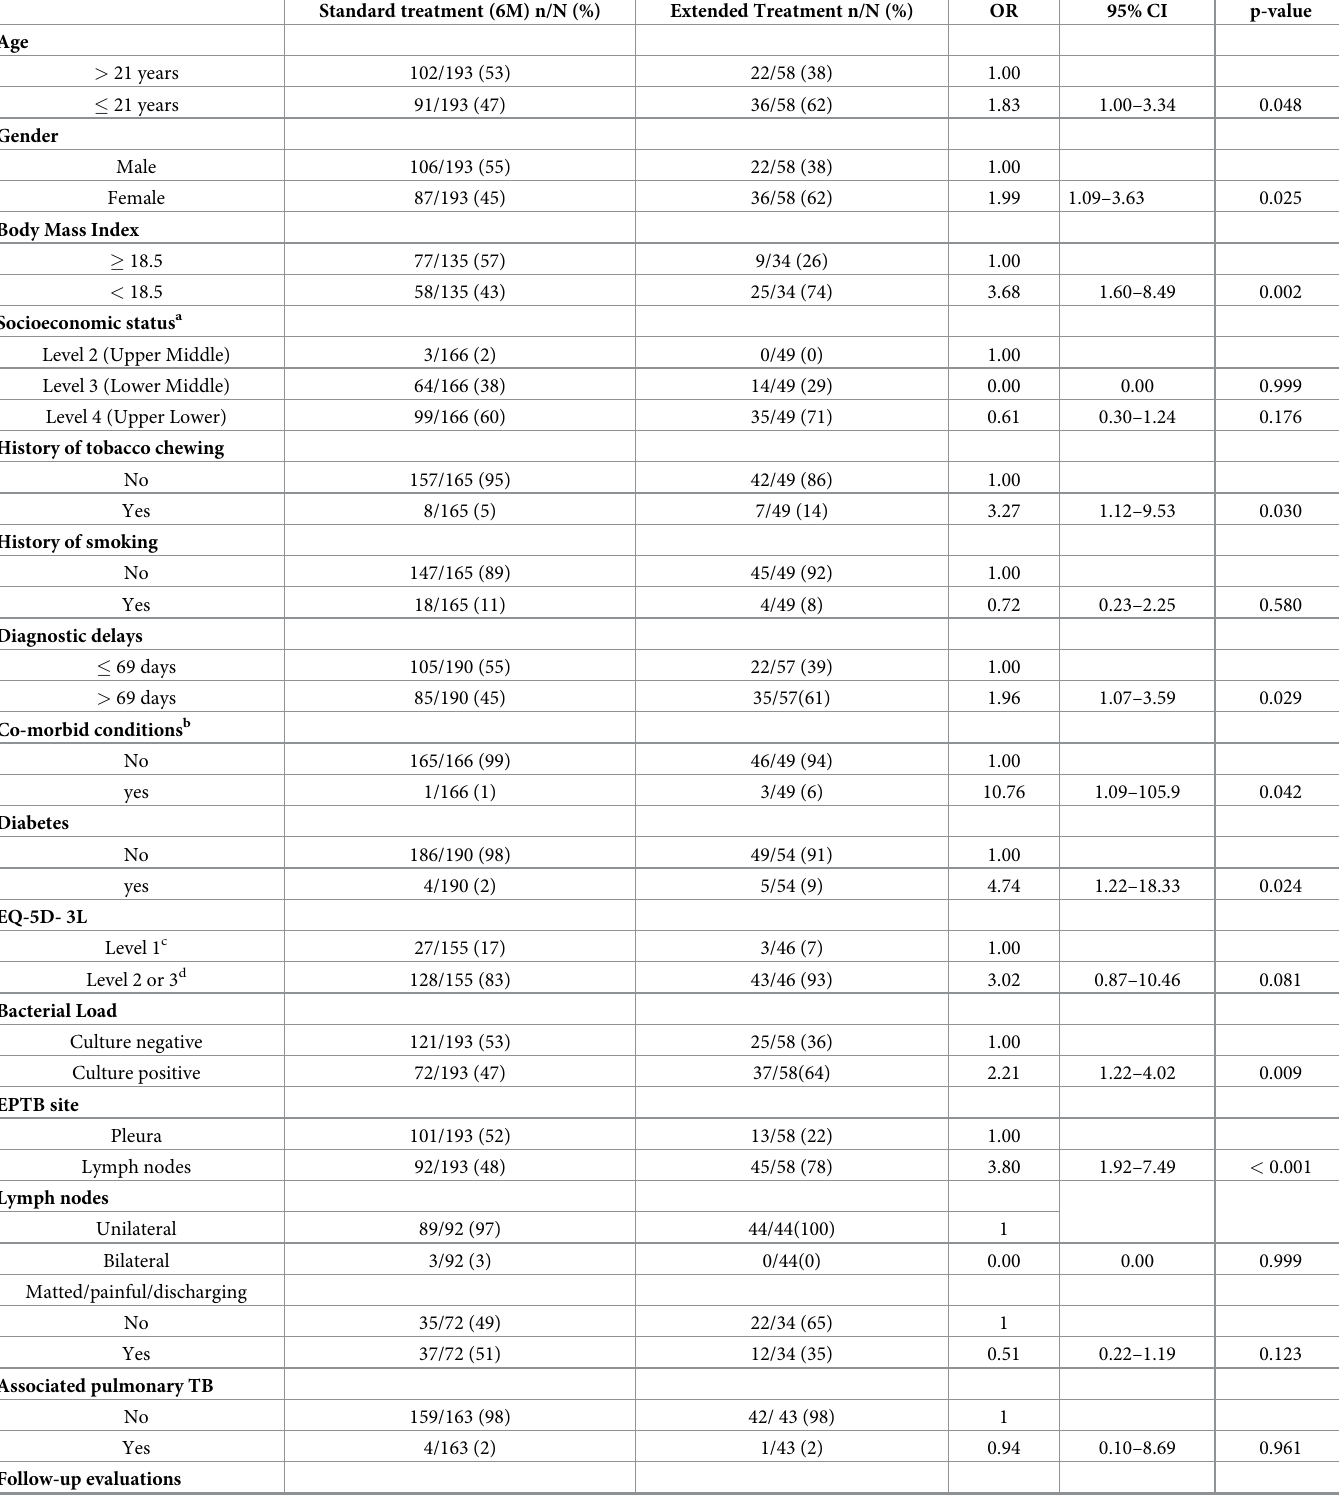
Table 1. Analysis of patient and disease related characteristics associated with prolonged treatment by univariable logistic regression